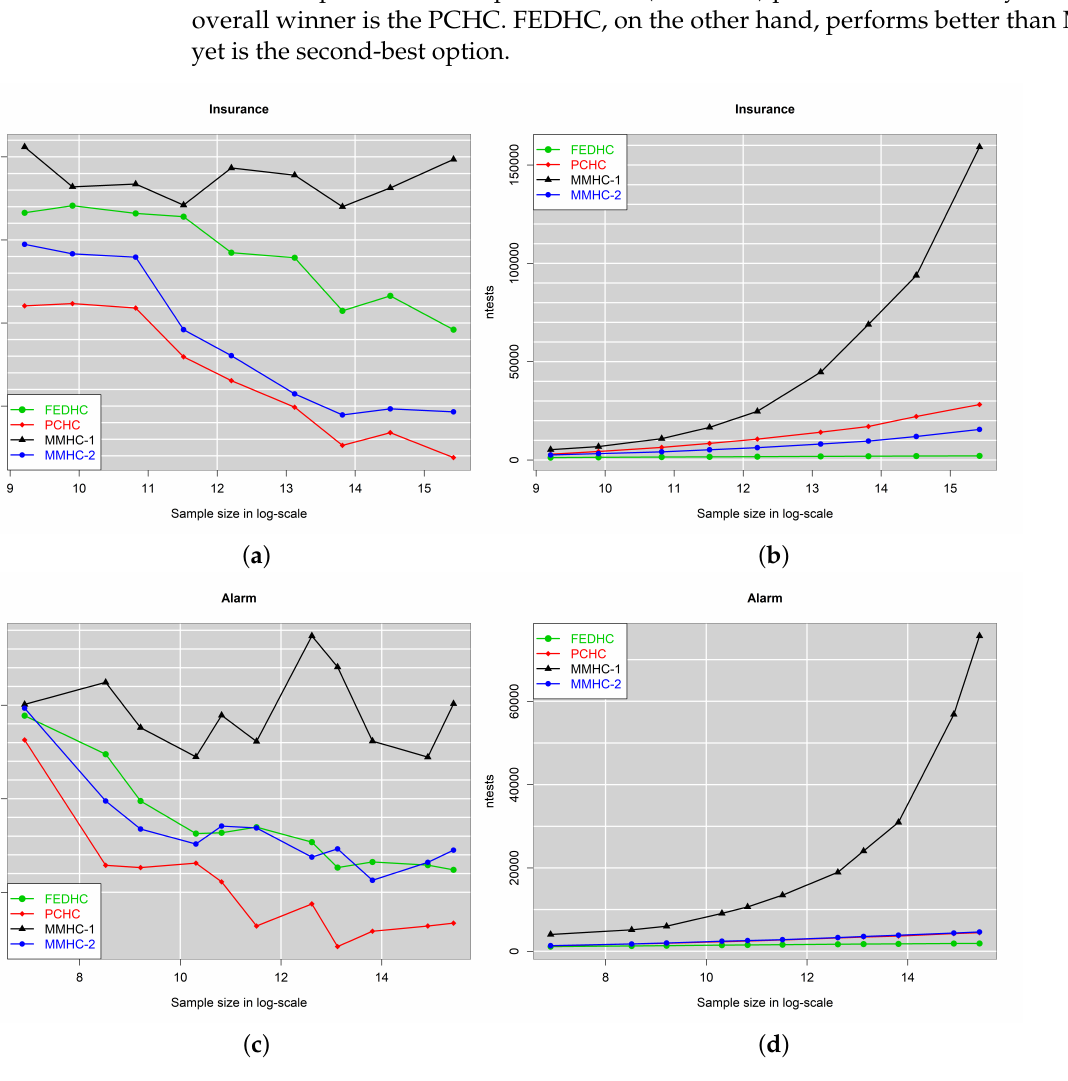
Figure 10. SHD and number of CI tests against log of sample size with categorical data. ( a , c ) SHD vs. log of sample size. ( b , d ) Number of CI tests vs. log of sample